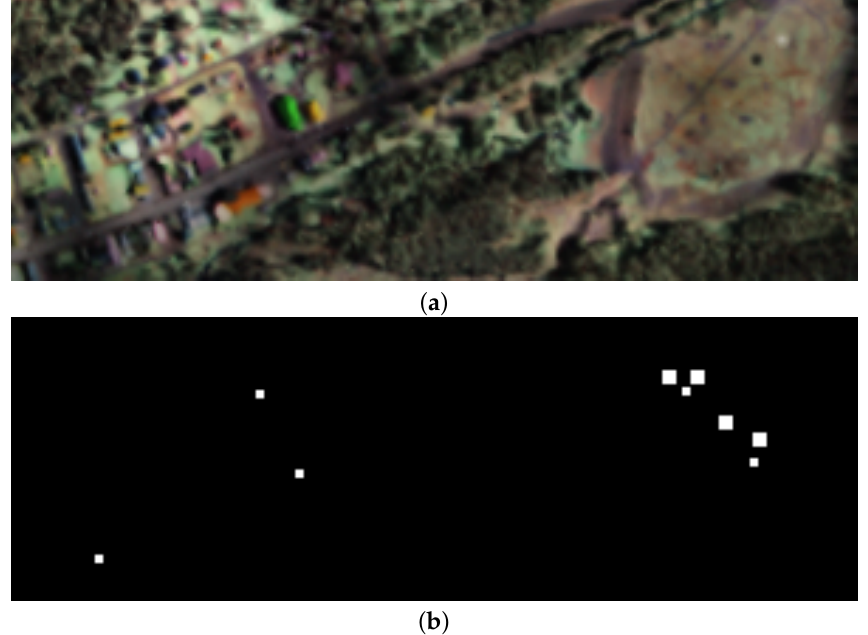
Figure 5. Illustration of the HyMap dataset: ( a ) false color (RGB: 60, 30, 20); ( b ) the ground-truth